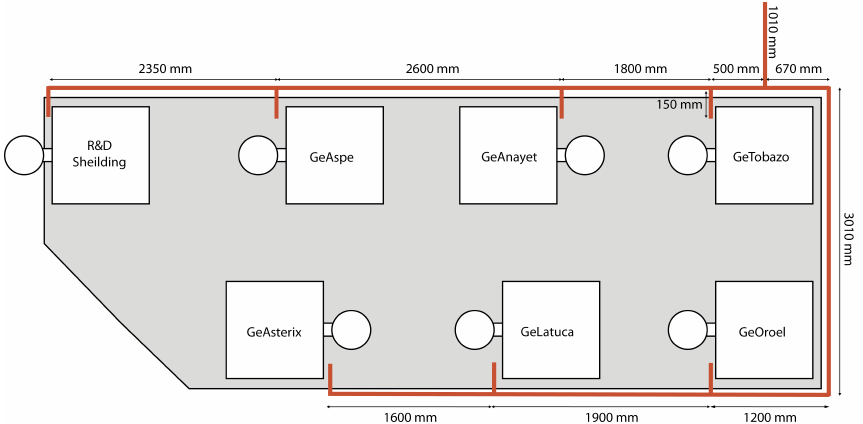
Figure 21. Schematic of HPGe positioning in Hall C. In red, the installation to supply ATEKO-Air to each detector.